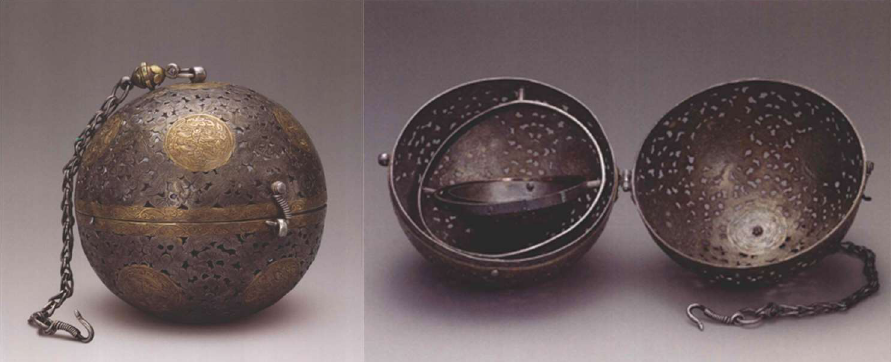
Figure 1. Liujin shuangfeng tuanhuawen loukong yin xiangnang 鎏金雙蜂團花紋鏤孔銀香囊 (Gilt double-bee, cluster-pattern, openwork silver sachet) from Famensi. Gilded silver. Diameter: 12.8 cm. Weight: 547 g. Chain: 24.5 cm. Tang Dynasty (618–907).